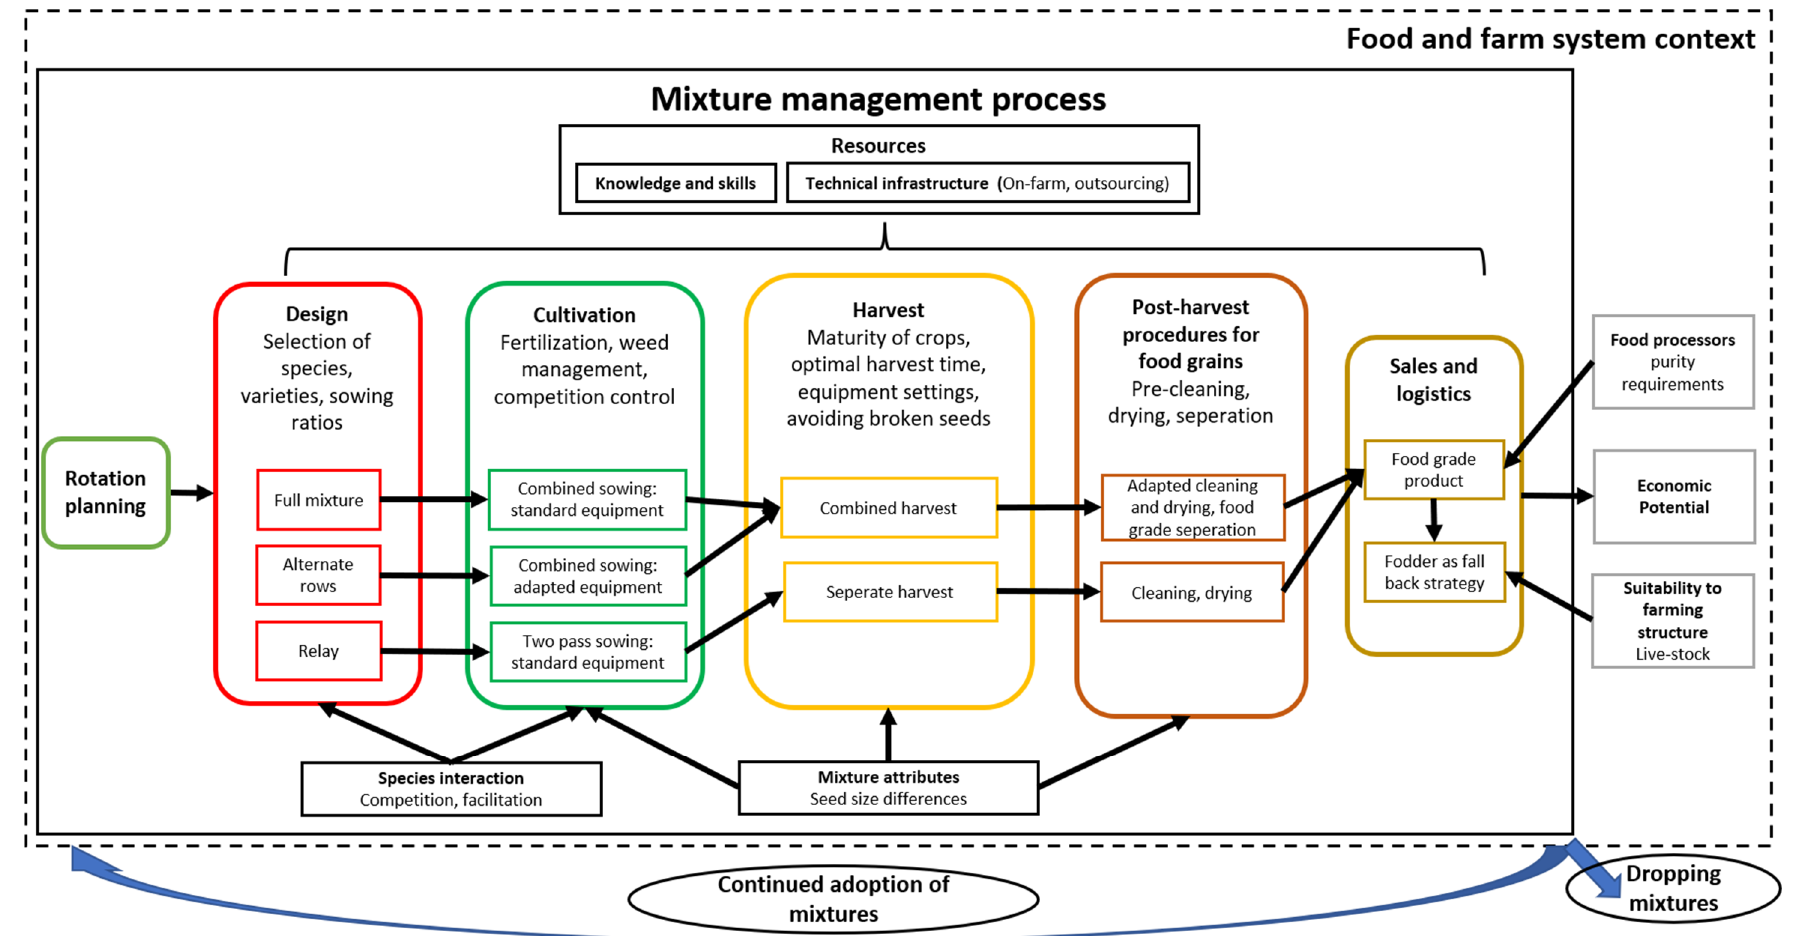
Figure 3. Social representation of the mixture management process in the context of the farming and food system. Colored frames show the steps in the management process and how choices in each step influences steps downstream in the process. Black frames show how species interactions, mixture attributes and resources influence mixture management. The social representation was interpretatively reconstructed from the interviews with farmers.